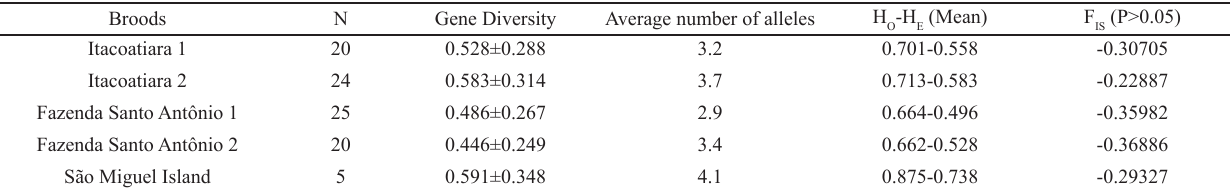
Table 2. Main genetic pattern for each brood analysed in Arapaima gigas . Note: H heterozygosity, F = fixation index. IS